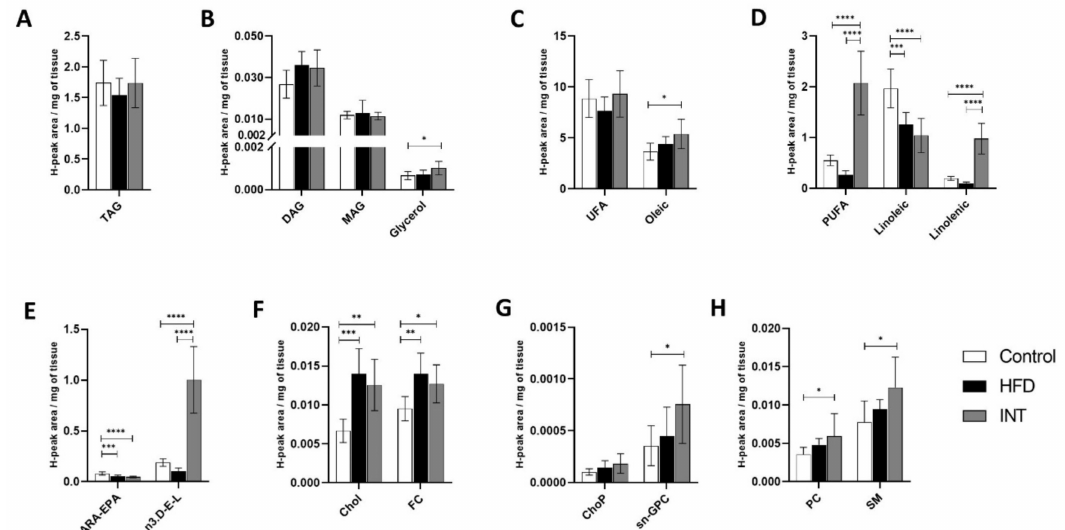
Figure 6. Alterations in metabolite lipid profile in eWAT. Representation of the changes induced by HFD and the intervention following the HFD on the presence of ( A , B ) glycerolipids, ( C – E ) fatty acids, ( F ) sterol lipids and ( G , H ) phospholipids and sphingolipids. Ctrl n = 8, HFD n = 8, INT n = 7. Y-axis values indicate H-peak area/mg of tissue. Data represented as mean ± SEM, one-way ANOVA and post-hoc Tukey’s tests, * p < 0.05, ** p < 0.01, *** p < 0.001, and **** p <